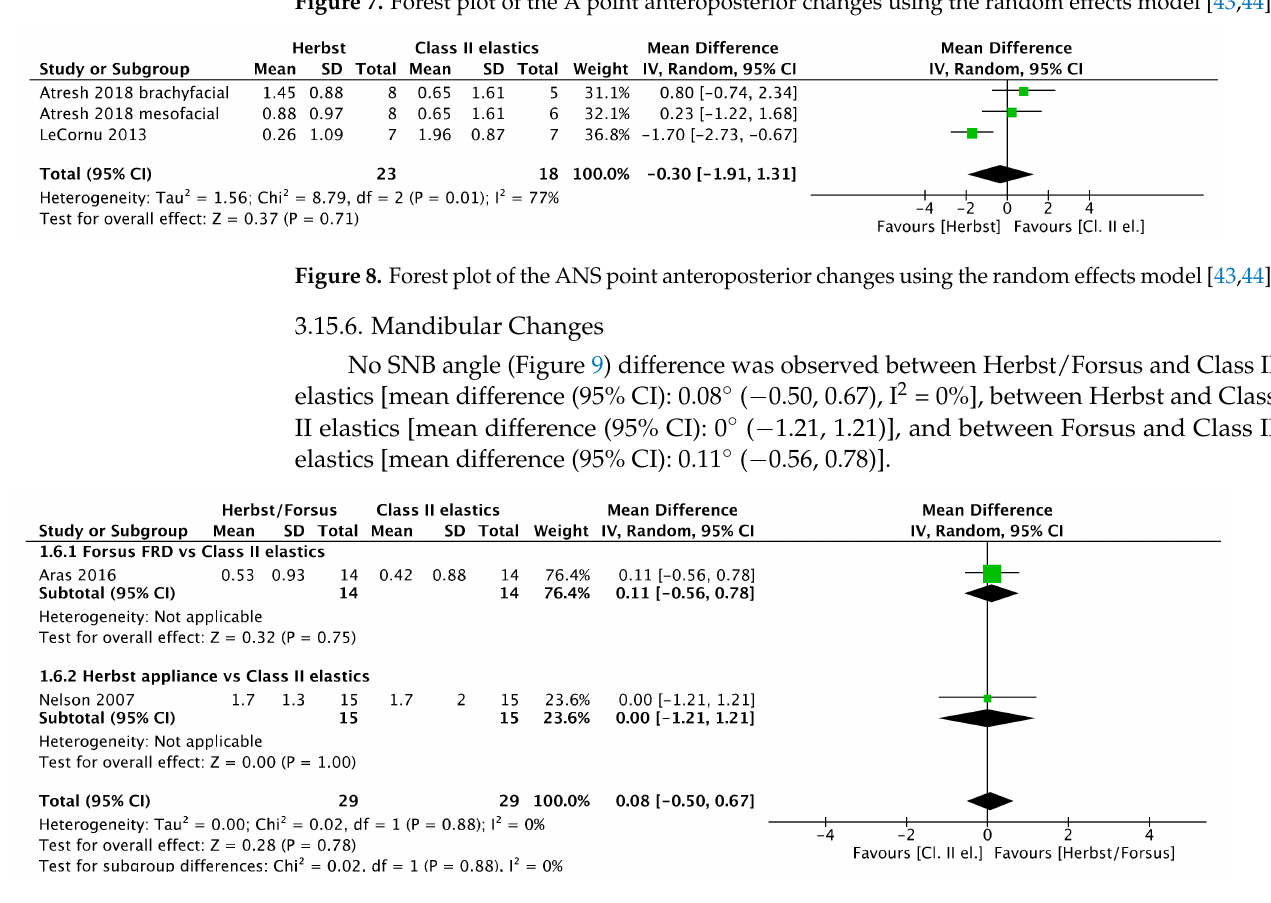
Figure 9. Forest plot of the SNB angle changes using the random effects model